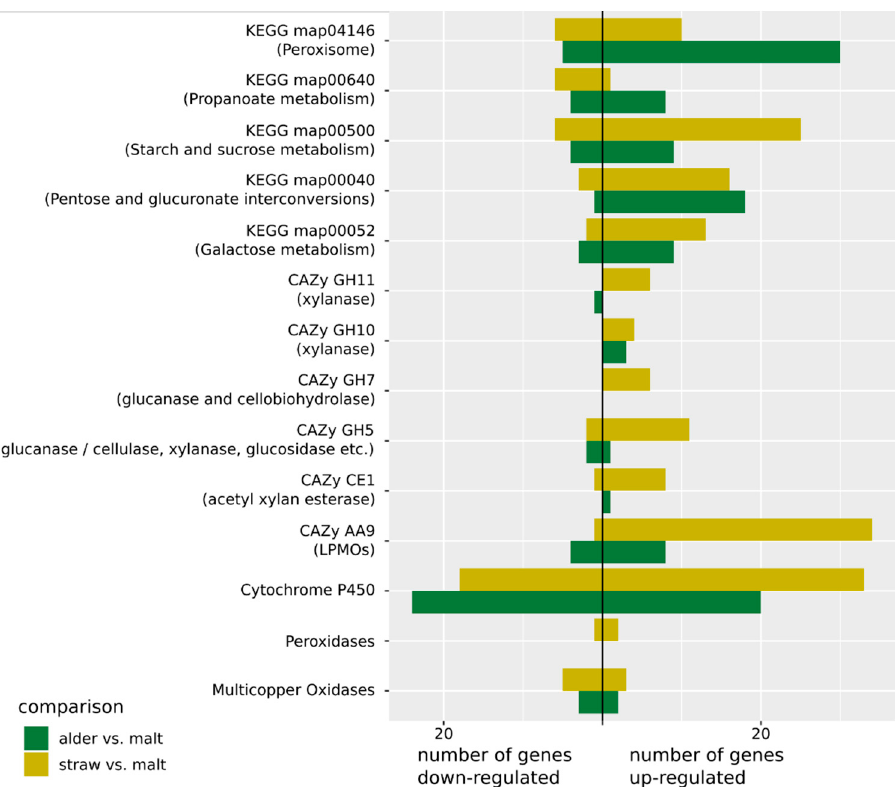
Figure 1. Number of up- and down-regulated genes in different gene groups for the comparison between wheat straw versus malt extract (yellow) and between alder leaves versus malt extract (green).